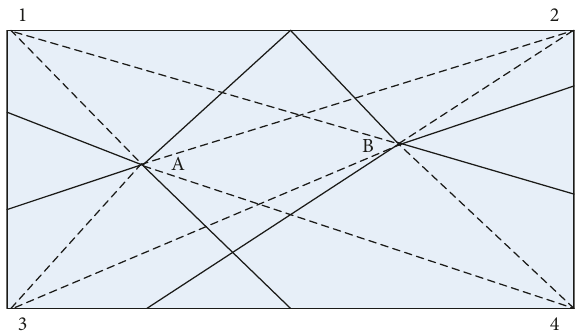
Figure 1: Detection principle of four-eye sensor touch